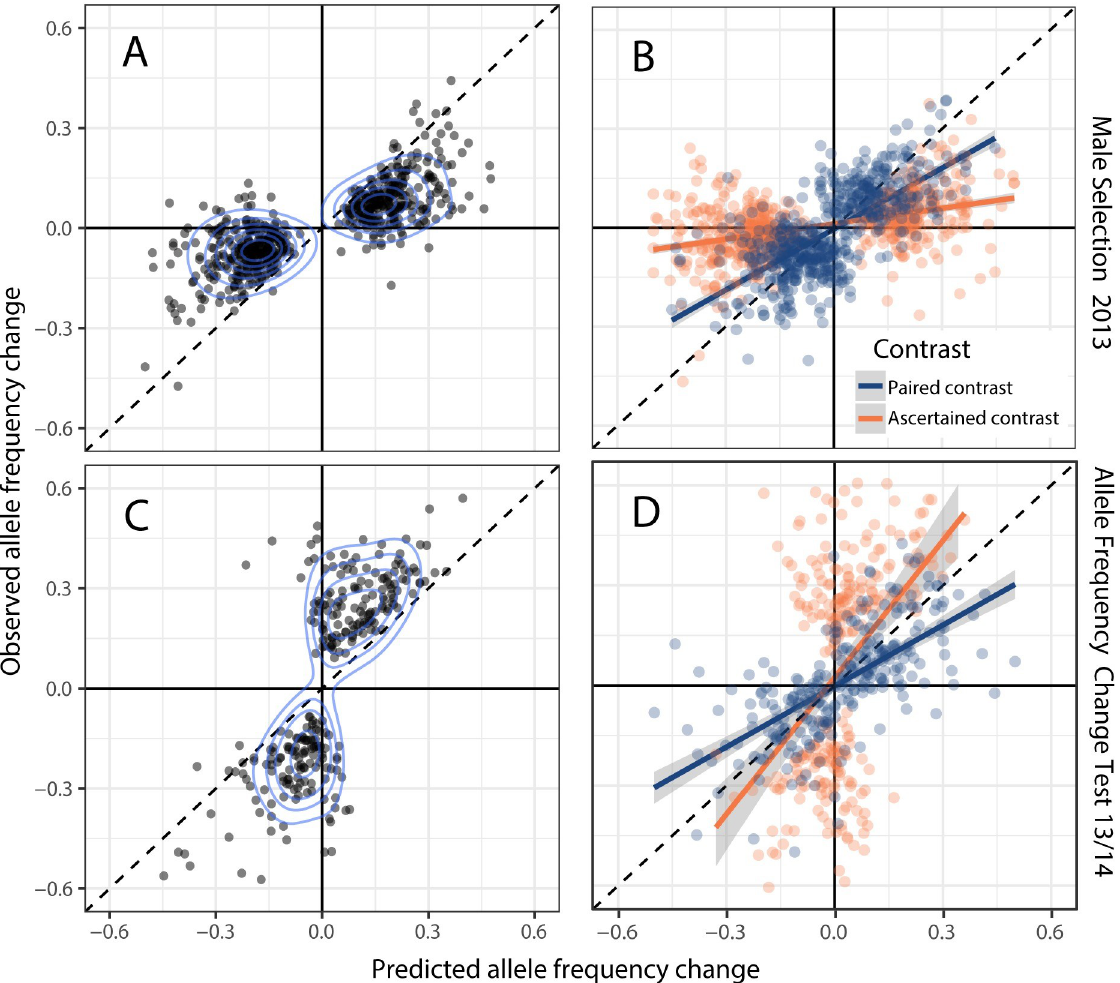
Fig 2. The observed allele frequency change (2013 adults to 2014 zygotes) is compared to predicted with SNPs chosen based on (A) significance for male selection in 2013 (n = 587) or (C) significance for the Change in Allele Frequency test (n = 274). Results are reported for all gene sets with a SNP with p < 10 − 5 . Contours indicate the density of points in panels A,C. For cross-validation (B, D), we split the data into two halves and performed model fits on each half. We chose an equivalent number of SNPs to the corresponding un-partitioned analyses with n = 587 in (B) to match (A) and n = 274 in (D) to match (C). For SNPs selected based on male selection (B), the “Ascertained” contrast is based on the predicted Δ p from the significant test (orange points) while the “Paired” contrast is based on the predicted Δ p from the other half of the data (blue points). (D) In the cross-validation for allele frequency change significant tests, the ascertained (orange) is the observed Δ p from the significant test and predicted Δ p from the other data half. Assignment is reversed because the allele frequency change test is based on the observed Δ